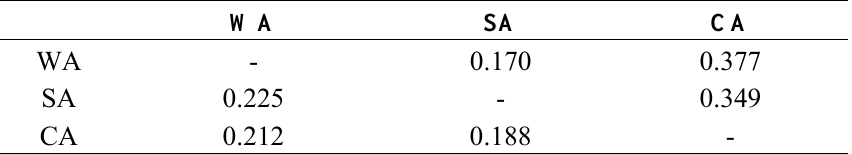
Table 3. Nei’s Distance pairwise comparisons above the diagonal and Fst pairwise comparisons below the diagonal for all populations, Western Australia (WA), Southern Australia (SA), and captive animals